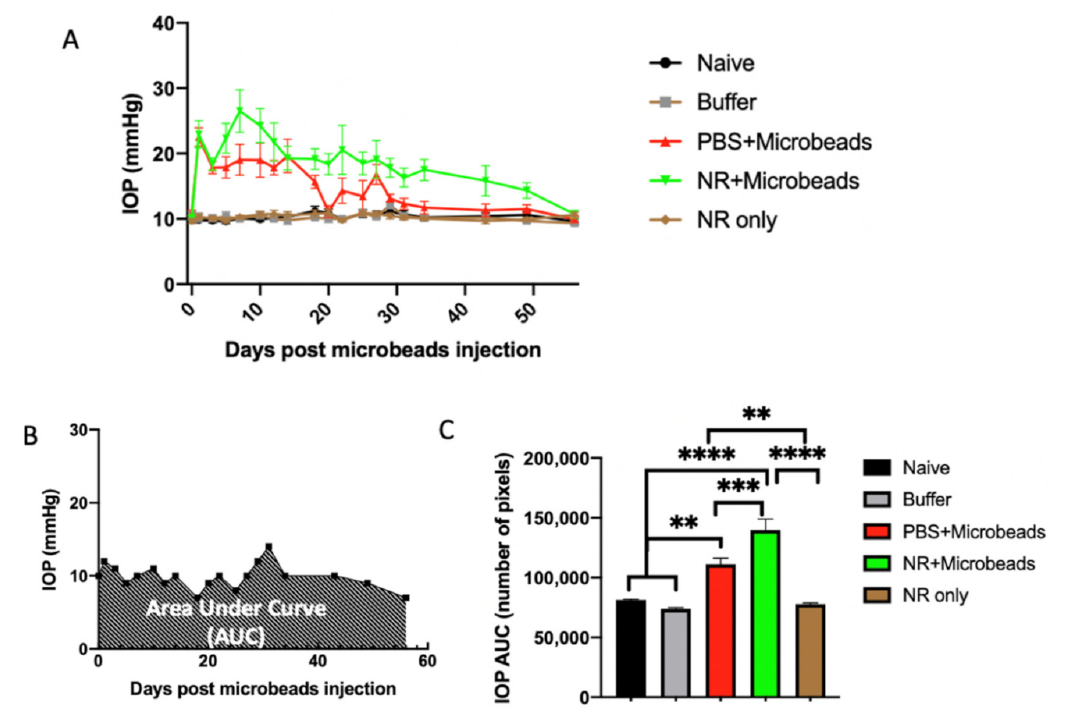
Figure 5. IOP changes over 2 months following microbead injection. ( A ). IOP was measured at the days given on the X-axis and averaged across all mice in each group. ( B ). Area Under the Curve (AUC) of IOP change was quantified by pixel counting using imageJ. This is an example of IOP AUC assessment on an individual eye from Naïve mouse. ( C ). Mean AUC of IOP change for each treatment group. The mice in the “Naïve” group (N = 10) did not receive microbead injection or any treatment; the mice in the “Buffer” group (N = 10) received buffer (HBSS) injection without any treatment; the mice in the “PBS+Microbeads” group (N = 19) received microbead injection and PBS i.p. injection; the mice in the “NR+Microbeads” group (N = 18) received microbead injection and NR treatment; the mice in the “NR only” group (N = 10) received NR treatment without anterior chamber injection. Microbead injection caused significant IOP AUC increases (compare red and green bars to black and gray bars). NR treatment in microbead-injected eyes (green bar) increased AUC IOP compared to PBS treatment (red bar). ** p < 0.01, *** p < 0.001, **** p < 0.0001 by one-way ANOVA with Newman-Keuls post-hoc test. Error bars represent